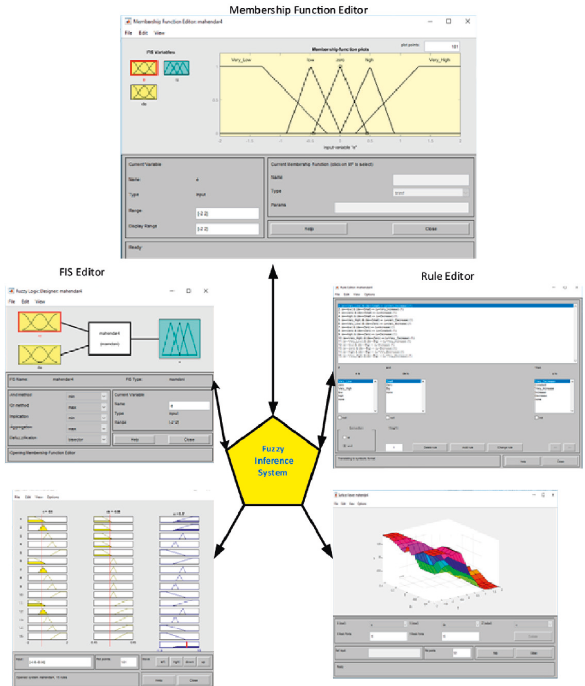
Figure 21: Fuzzy inference system with membership